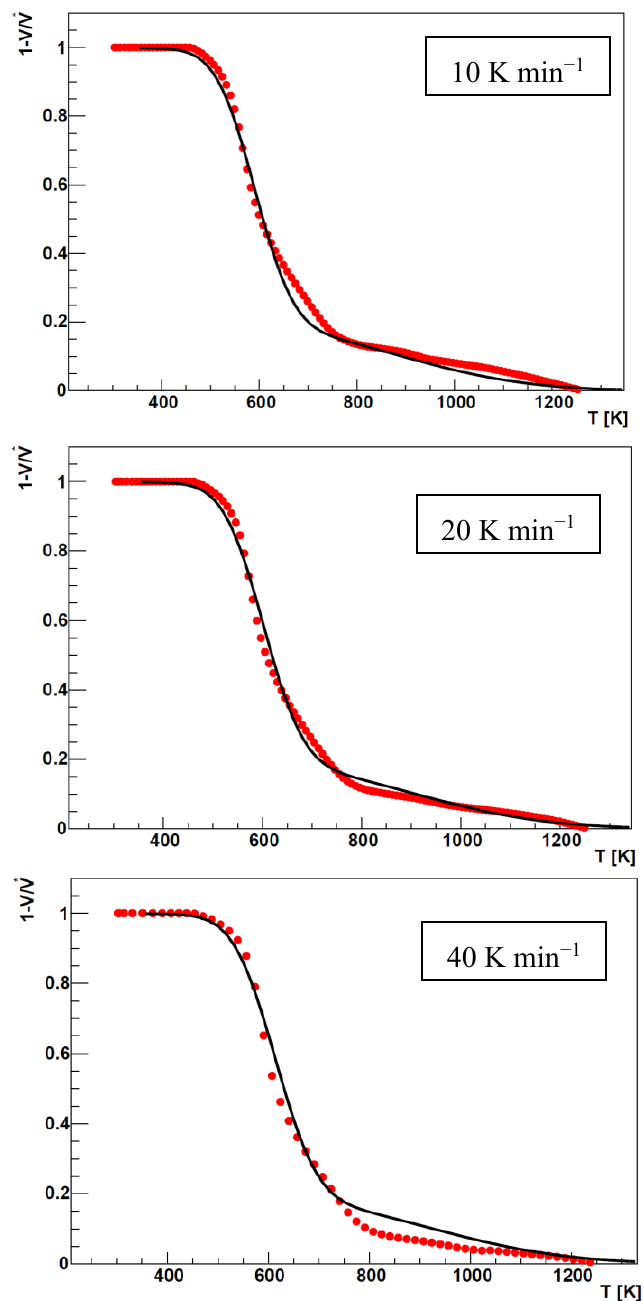
Figure 6. Comparison between experimental data taken at different heating rate (red points) and 2-DAEM simultaneous fit (black line) for the